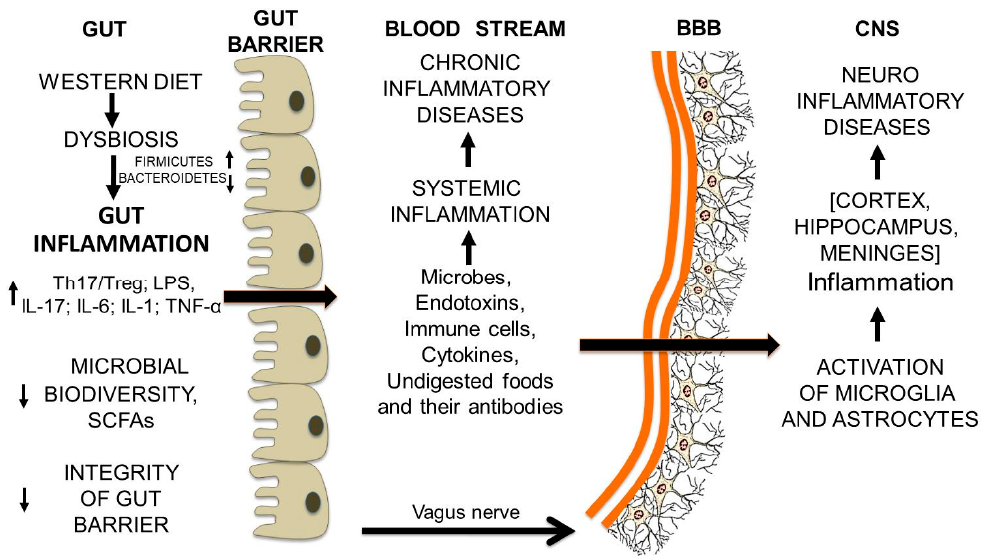
Figure 8. From Westernized dietary habits to neuroinflammation and neurodegenerative diseases: a schematic representation.